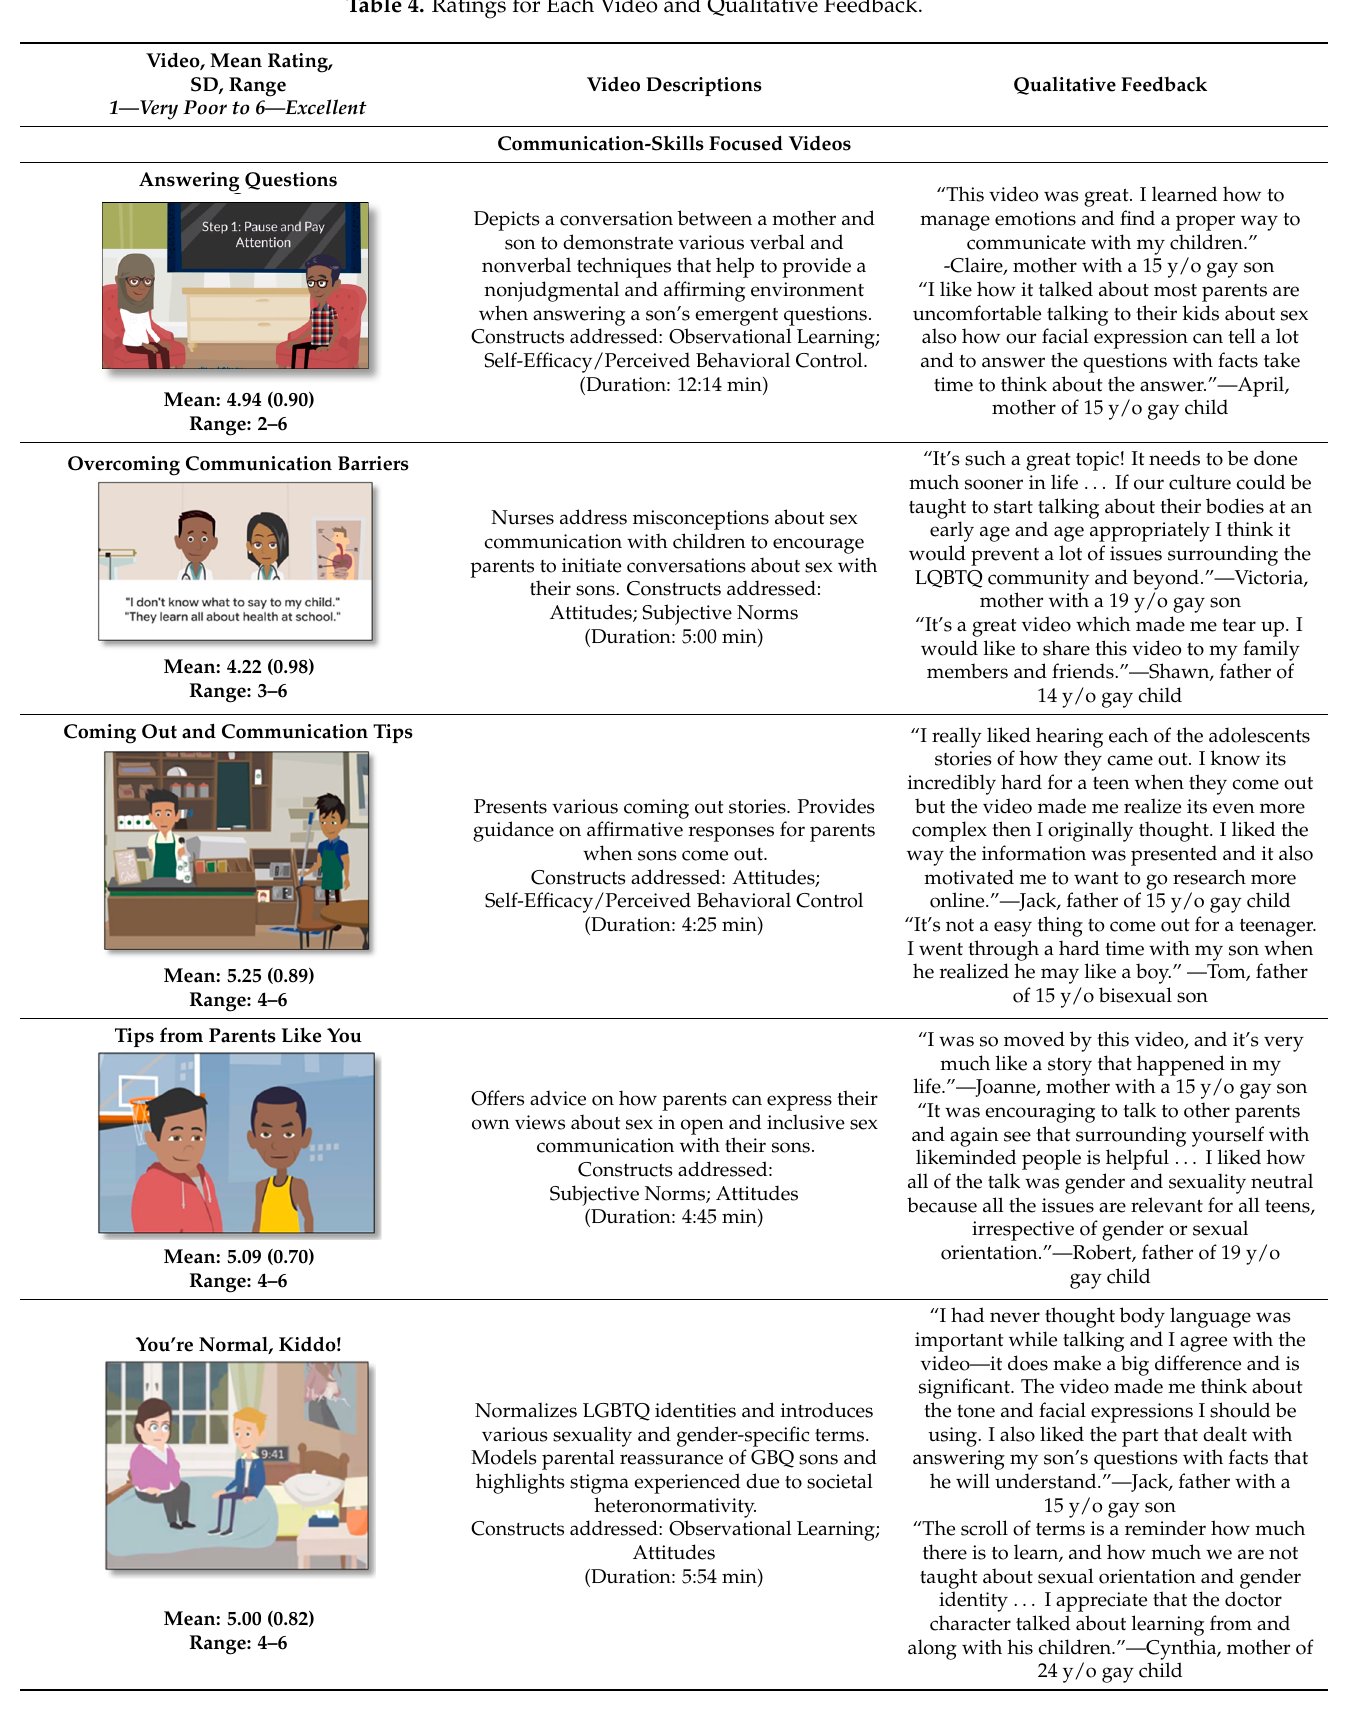
Table 4. Ratings for Each Video and Qualitative Feedback.